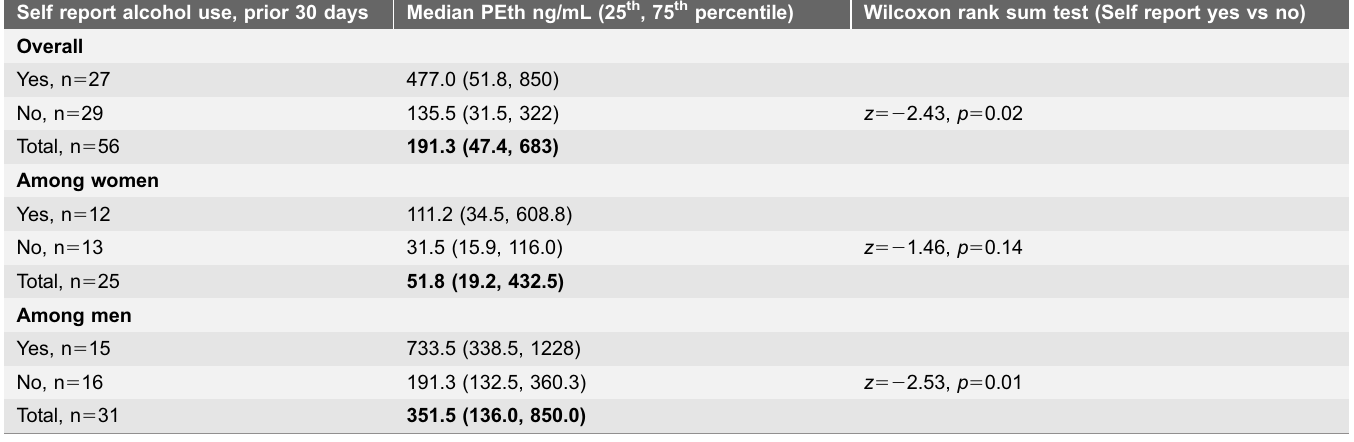
Table 3. PEth results among those with PEth . 8 ng/mL, by self-reported alcohol consumption and by sex. Self report alcohol use, prior 30 days Median PEth ng/mL (25 th , 75 th